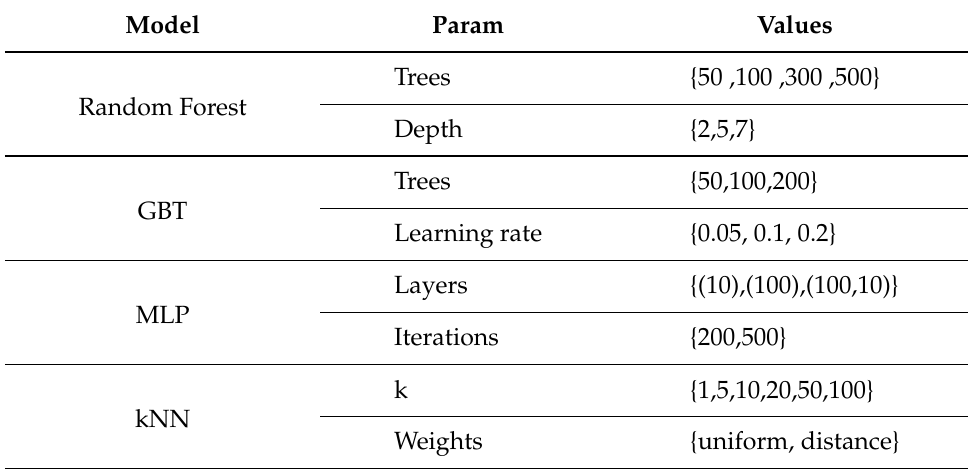
Table 1. The hyperparameters used for prediction model